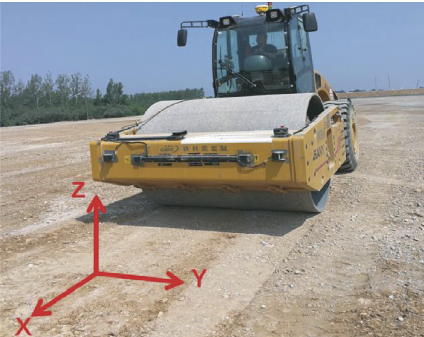
Figure 7: Schematic diagram of overall coordinate system in the field test.